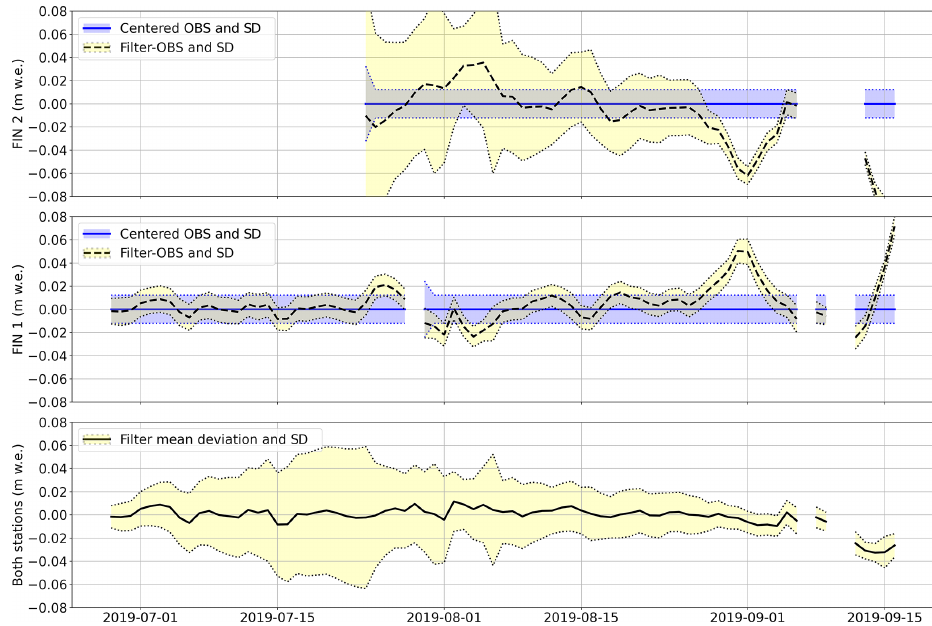
Figure C1. Temporal evolution of the ensemble mass balance state at stations FIN 1 and FIN 2. In the top two panels, the evolution of the mean and standard deviation of the filter (black lines and yellow shaded area) around the centered observations (blue lines and blue shaded area) is shown. In the bottom panel the mean deviation of the filter from the observations at both stations is shown.